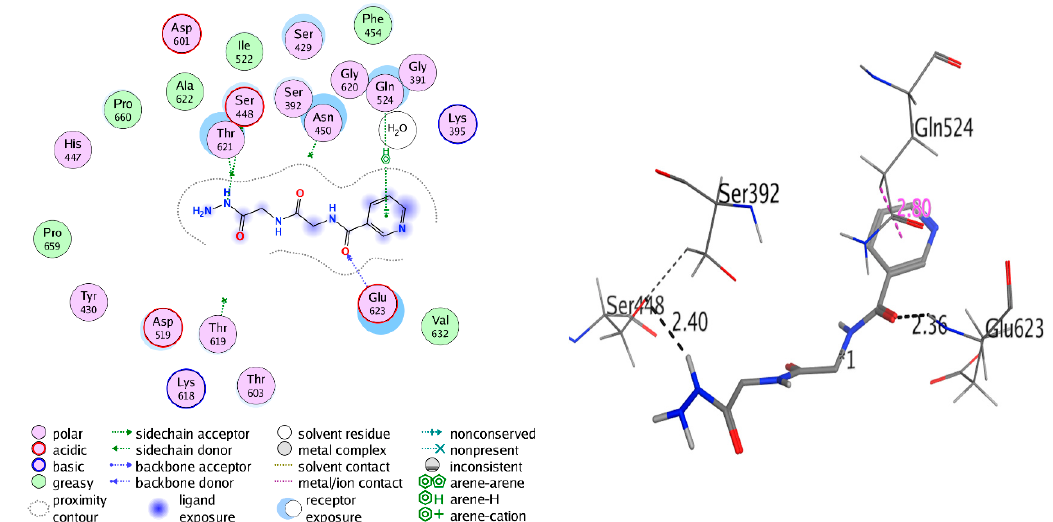
Figure 3. 2D and 3D interaction of compound 4 with 3VSL.